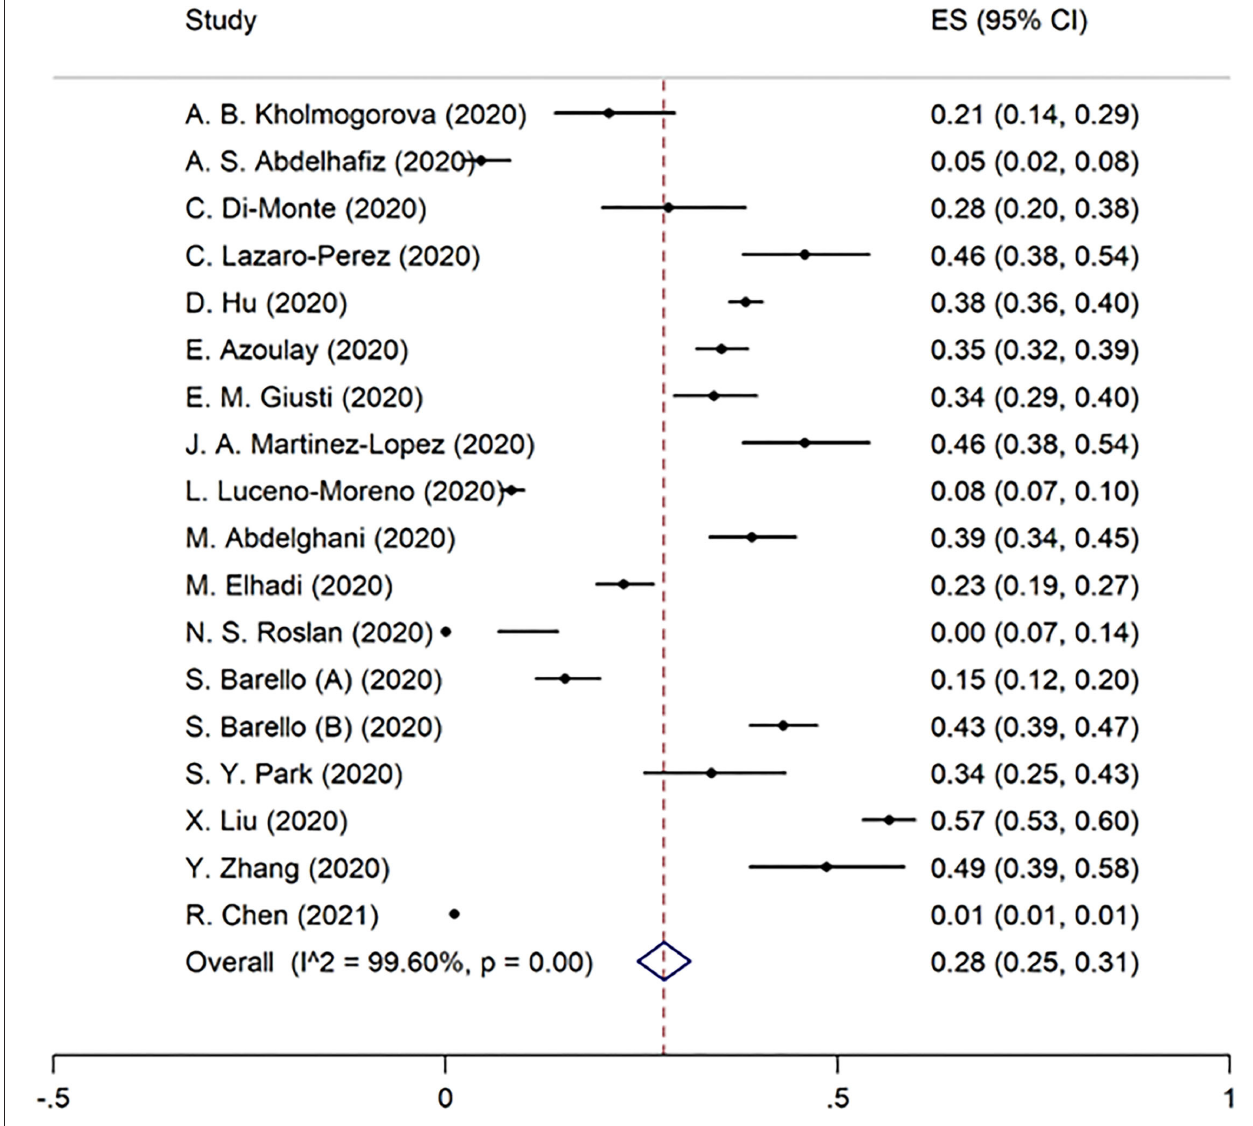
related to the management of COVID-19 patients